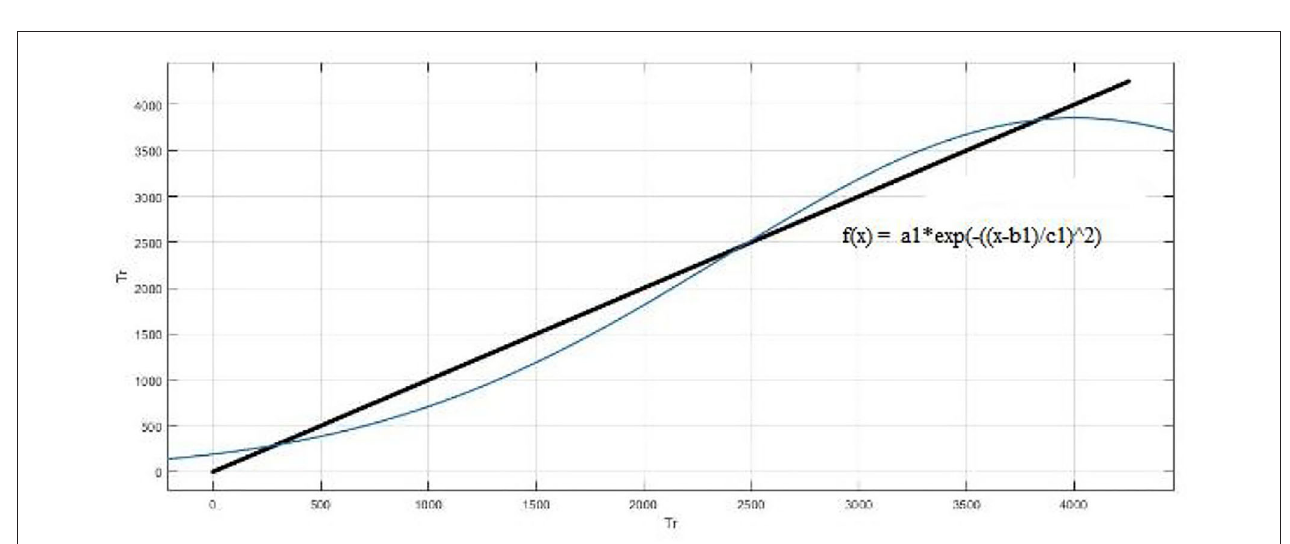
FIGURE 12 | Customized fitting model with f (x) = a*[sin(x − pi)] + b*[(x − 10) 2 ] + c.